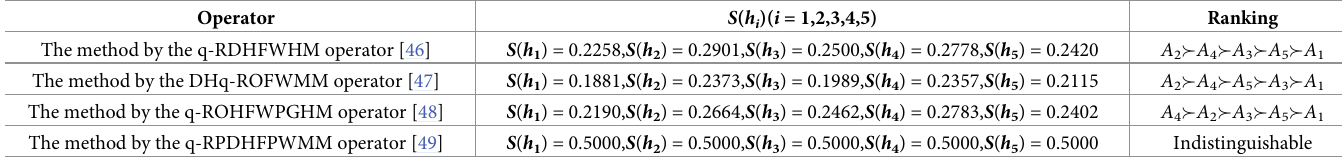
When the parameter q changes, the score of the candidate address first increases and then decreases with the increase of q , and finally tends to be stable. At the same time, the sorting result of candidate addresses has no change. But when q is greater than 50, the support Table 4. The score value and ranking results based on different operators.